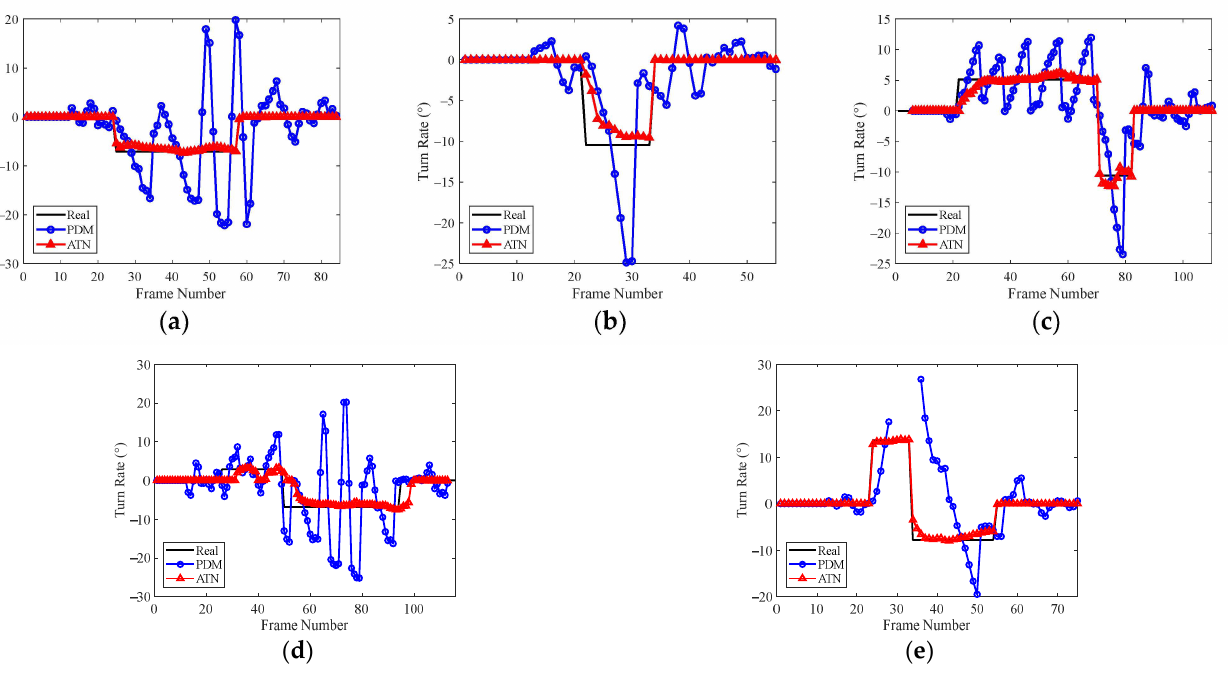
Figure 12. Result comparisons of turn rate estimate: ( a ) target 1, ( b ) target 2, ( c ) target 3, ( d ) target 4, and ( e ) target 5.